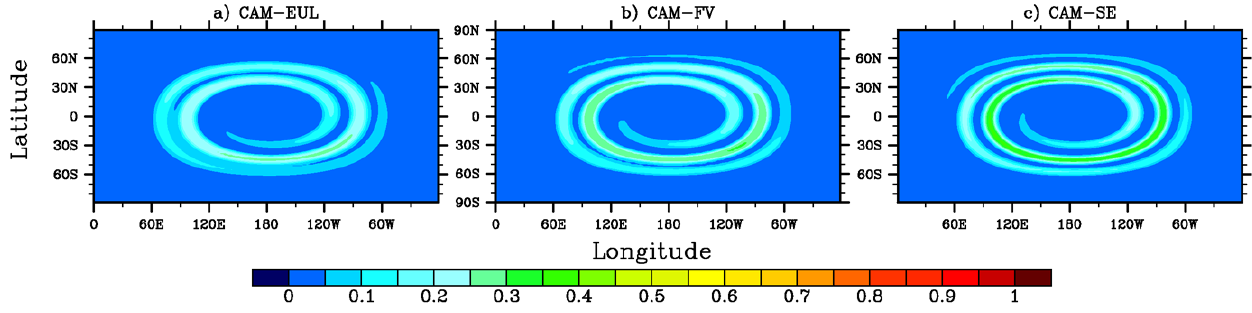
Fig. 7. Tracer mixing ratio results using, (a) CAM-EUL, (b) CAM-FV (PPM) and (c) CAM-SE for test 2 at time t = T . These plots can be compared with the reference solution averaged onto the coarse resolution grid in Fig. 2.